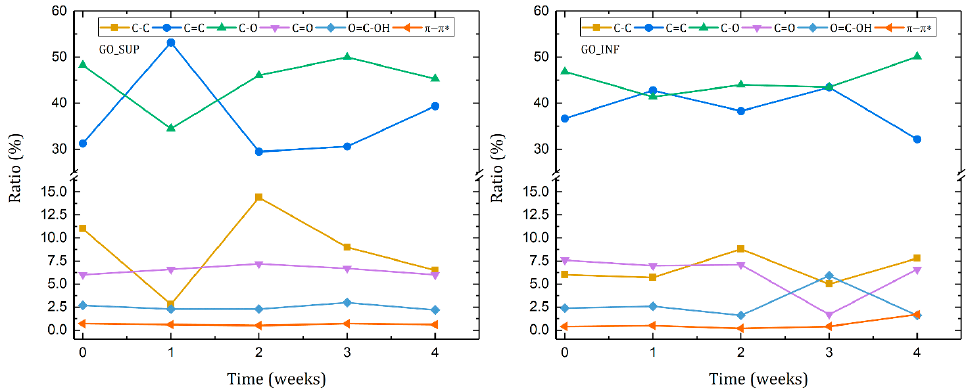
Figure 11. Peak ratios of the deconvoluted C1s core-level spectra of the dried GO_SUP ( left ) and GO_INF ( right ) samples over the course of the four weeks after the synthesis.